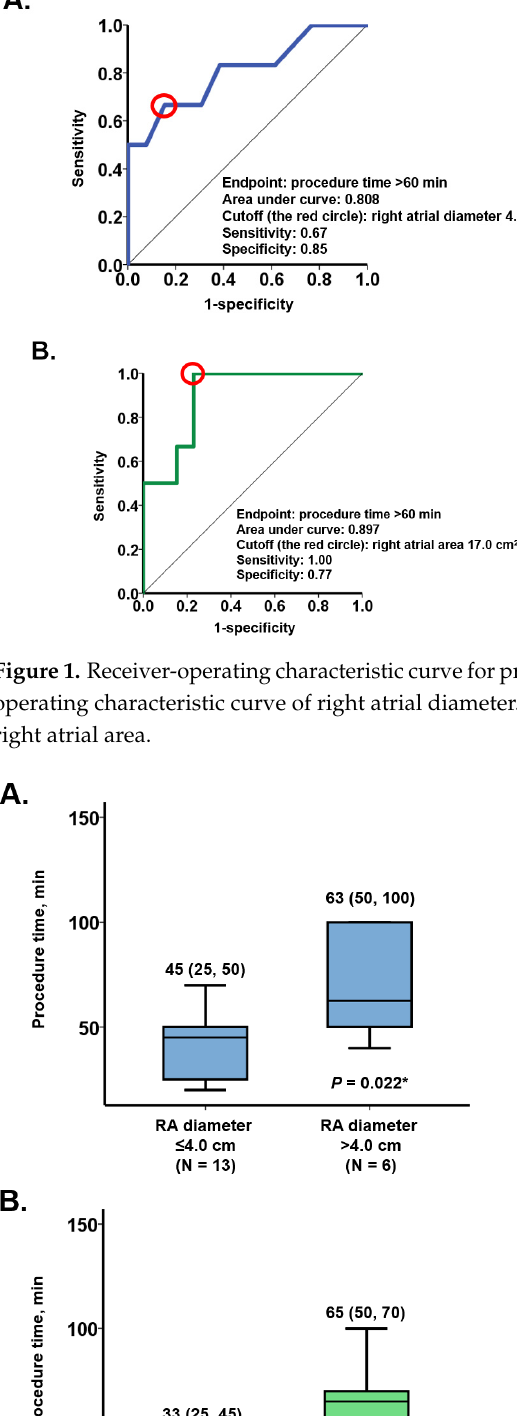
Figure 2. Comparison of procedure time between the two groups according to the cutoff that best discriminates procedure time > 60 min. ( A ) Right atrial diameter; ( B ) right atrial area. RA = right atrium. * means significant difference.